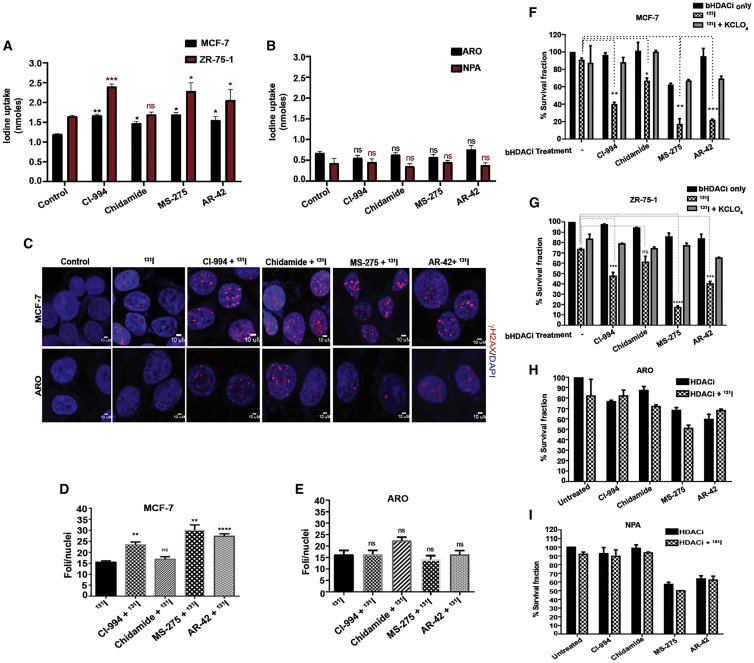
bHDACi Treatment Elevates the Function of NIS, thus Leading to Enhanced 131I -Mediated Cell Death in BC(A and B) Graphs showing the amount of iodine uptake (nmoles) in MCF-7, ZR-75-1 and ARO, NPA cells, respectively. Error bars indicate SEM. (C) γH2AX staining (red), indicating DNA damage response in MCF-7 and ARO cells after 131I treatment. Blue indicates nucleus staining using DAPI. Scale bar, 10 μm distance. (D and E) Graphs showing the quantification of the average number of γH2AX foci per nucleus, measured from at least 50 cells in MCF-7 and ARO cells, respectively. Error bars indicate SEM. (F and G) Graphs showing the survival fraction of MCF-7 and ZR-75-1 cells, respectively, after 131I treatment in the presence or absence of bHDACi treatment. 30 μM KCLO4 is used as a NIS-specific blocking agent for iodine transport. (H and I) Graphs represent results of similar experiment as in (F) and (G) for TC cell lines ARO and NPA, respectively. Error bar, SEM (∗∗p ≤ 0.01; ∗p ≤ 0.05).